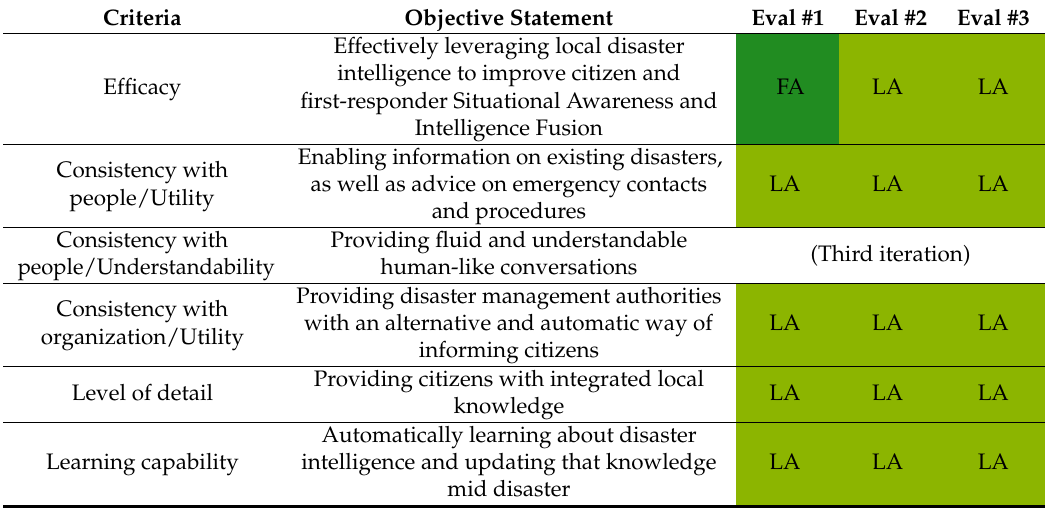
Table 8. Results of the second DSRM